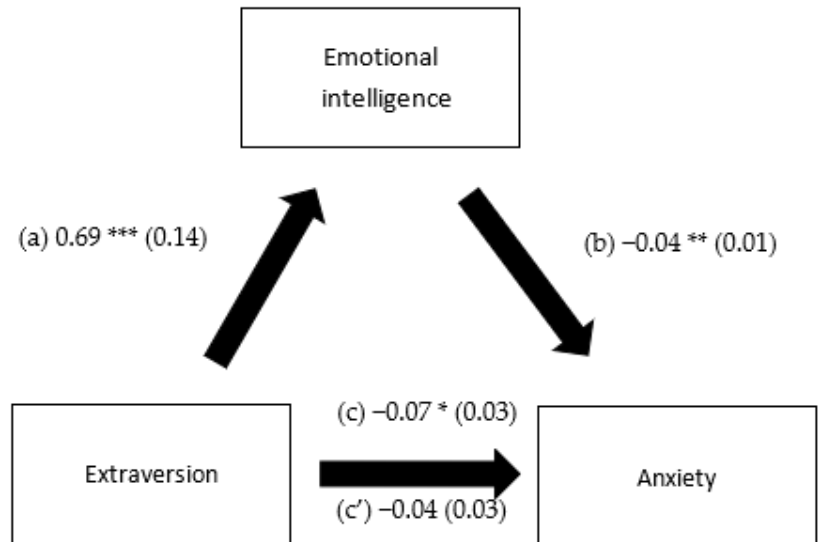
Figure 3. (a) Relation between extraversion and emotional intelligence (R 2 = 0.294); (b) relation between emotional intelligence and anxiety (R 2 = 0.344); (c) total effect of the relation between extraversion and anxiety (R 2 = 0.325); and (c’) direct effect of the relation between extraversion and anxiety. Numbers are displayed as regression coefficients (standard error). * p < 0.05; ** p < 0.01; *** p < 0.001.